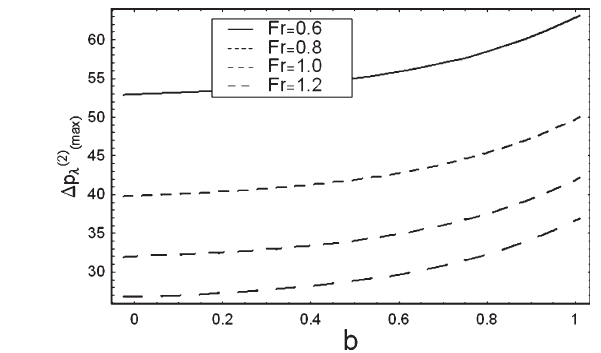
Fig. 10. Effect of Froud number Fr on variation of (cid:16)p (2) with λ b for a = 0 . 5, θ = 0 . 0001, d = 1 . 5, Re = 10, (cid:15) = 0 . 02, β = 0 . 1, sin α = 0 . 2 and φ = π/ 4.